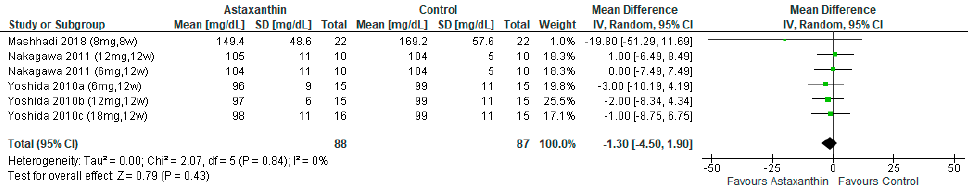
Figure 3. Forest plot of the effect of astaxanthin on fasting blood glucose [26–28]. Bold means total data.